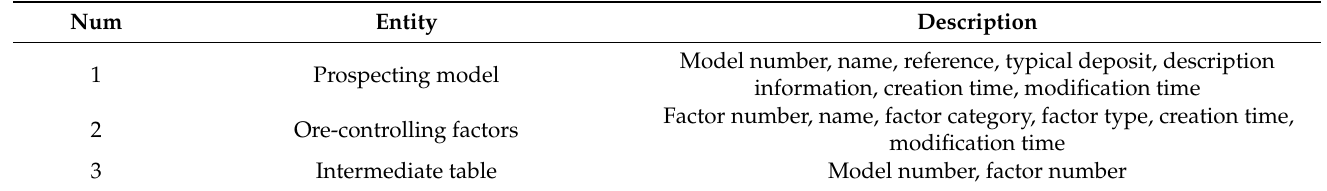
Table 1. Entity description table of the conceptual prospecting model